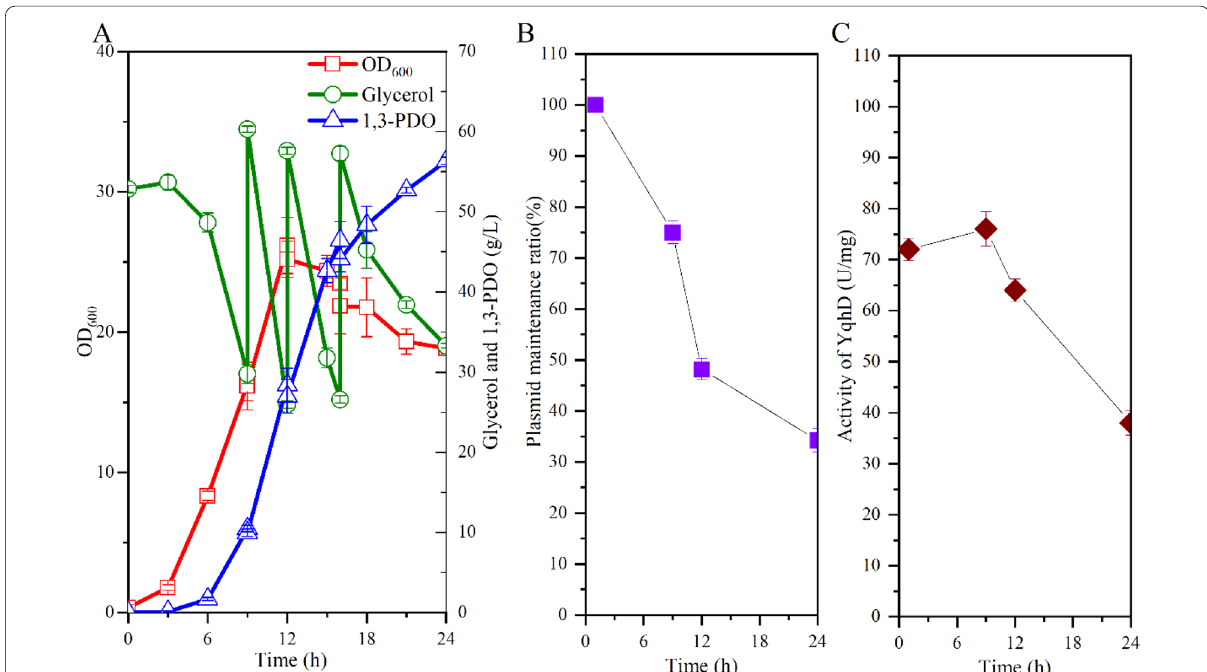
Fig. 2 Plasmid stability of V. natriegens VN10 during fed-batch fermentation. A Fermentation profiles of strain VN10; B Plasmid maintenance ratio during fed-batch cultivation; C Activity of YqhD during fed-batch cultivation. To maintain the stability of plasmid, 100 mg/L of ampicillin was added in the fermentation medium